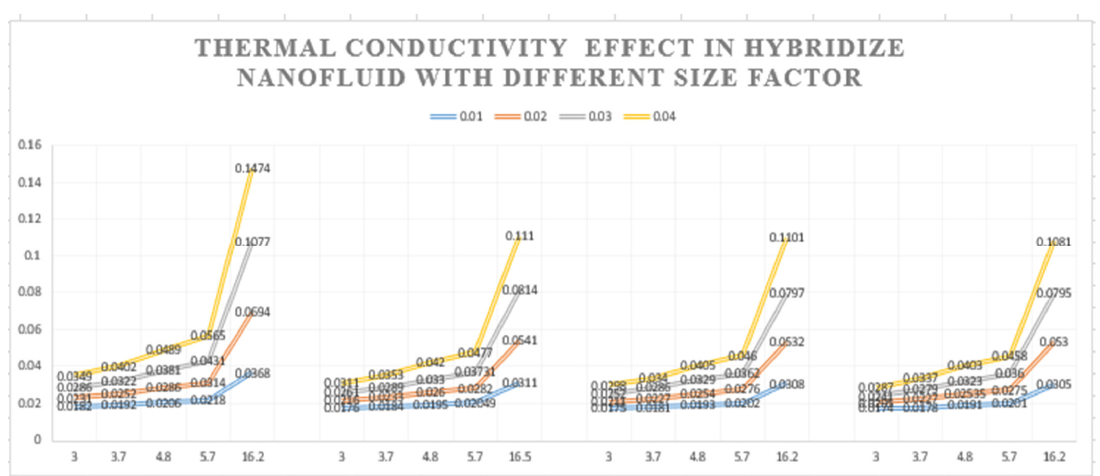
Figure 3. The impact of the hybrid nanoparticle size on thermal conductivity coloration.